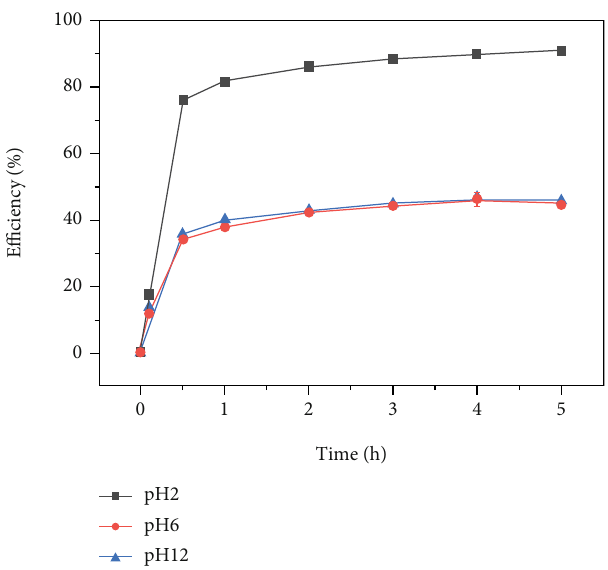
Figure 14: Evaluation of the e ff ect of pH on biochar 1 (5 g.L -1 ) adsorbability of methyl